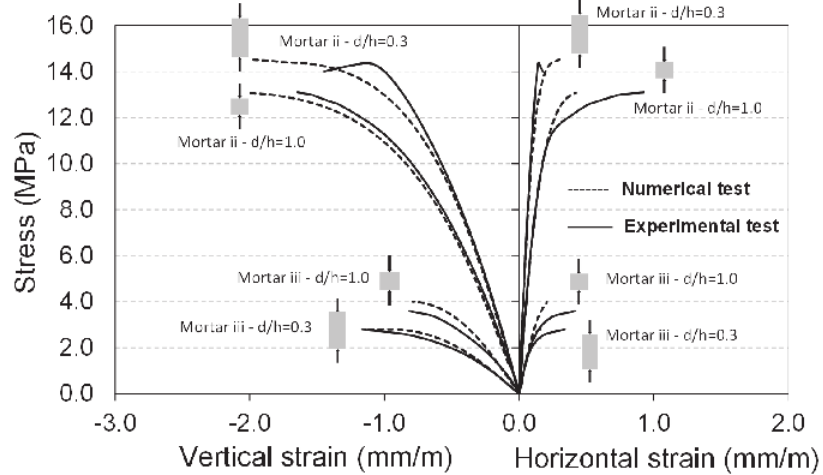
CTE30 isoparametric solid pyramid element